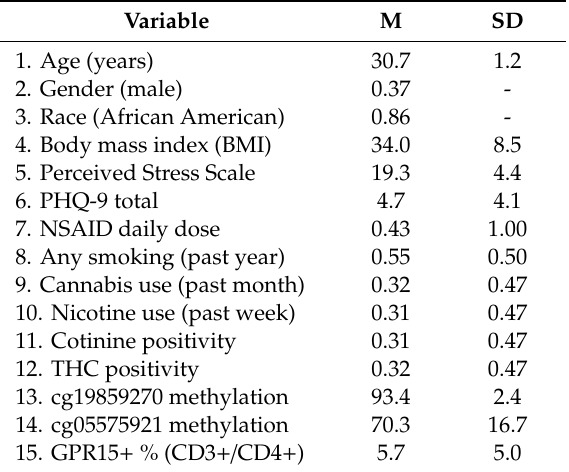
Table 1. Means and standard deviations for study variables, all subjects ( n =